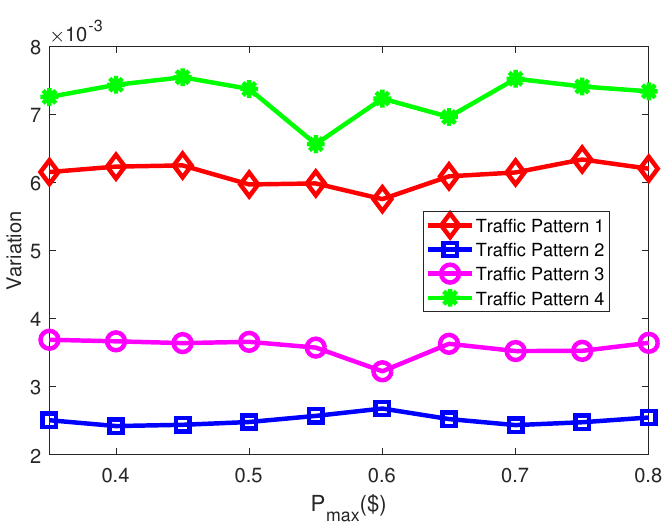
Figure 16. Impact of P max on sites’ variation in PARM.